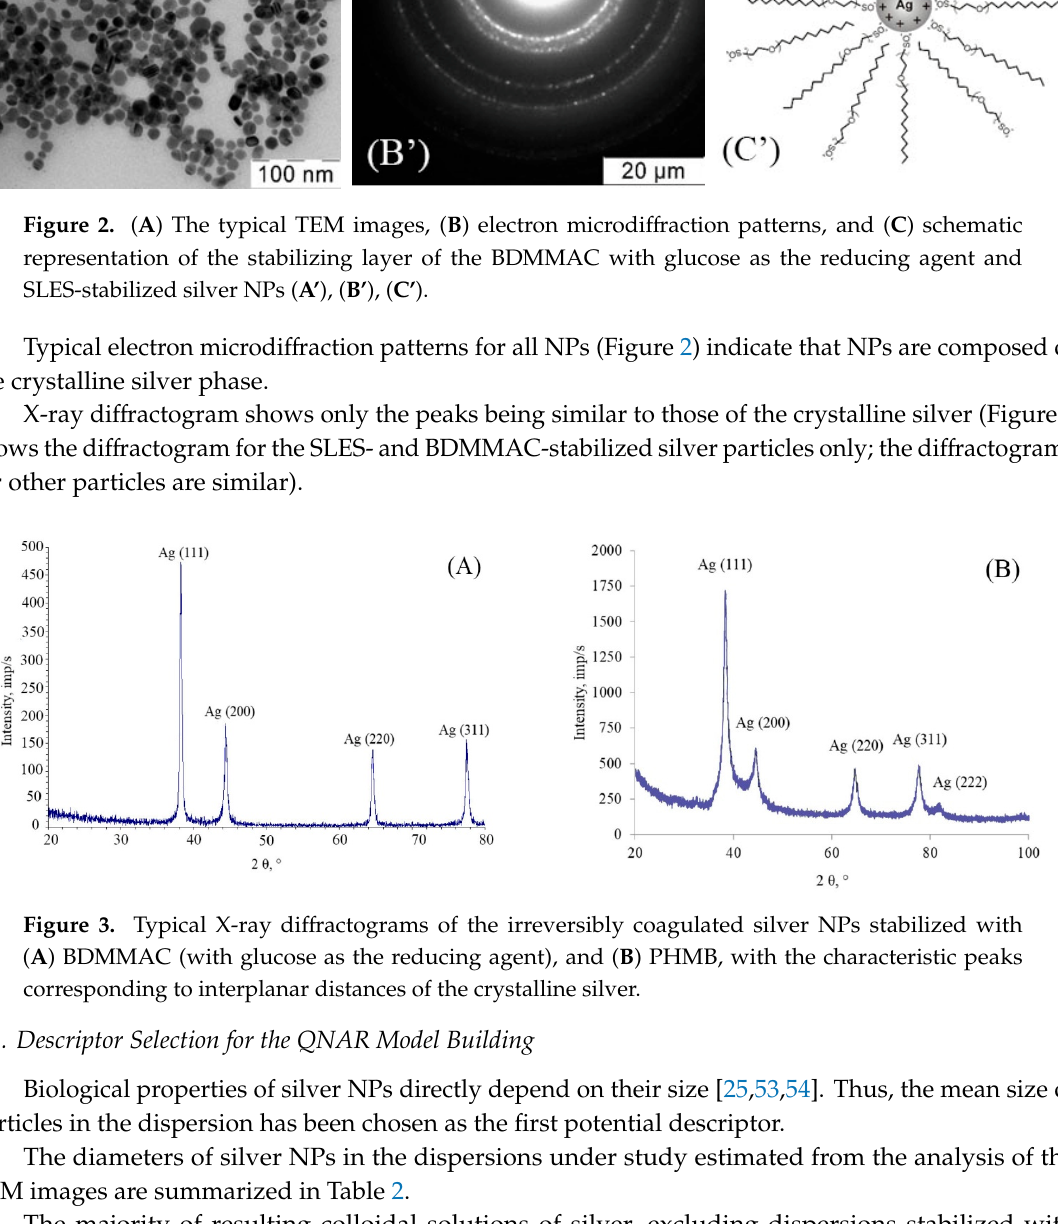
Table 2. Characteristics of the dispersions of silver NPs; d – mean diameter of silver NPs; S sp —specific surface; c max (KCl)—KCl concentration initiating the dispersion coagulation; k `—averaged effective rate constant for oxidation of silver NPs by H 2 O 2 .